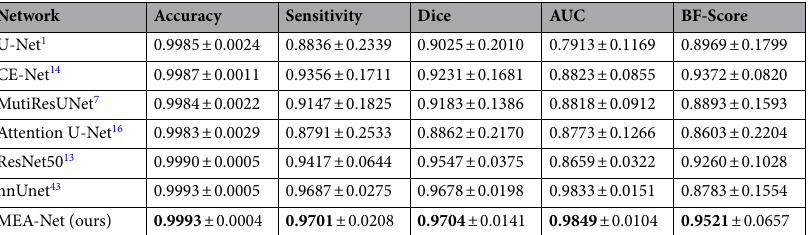
Table 3. Performance comparison on lung segmentation (mean ± standard deviation). Significant values are in bold.